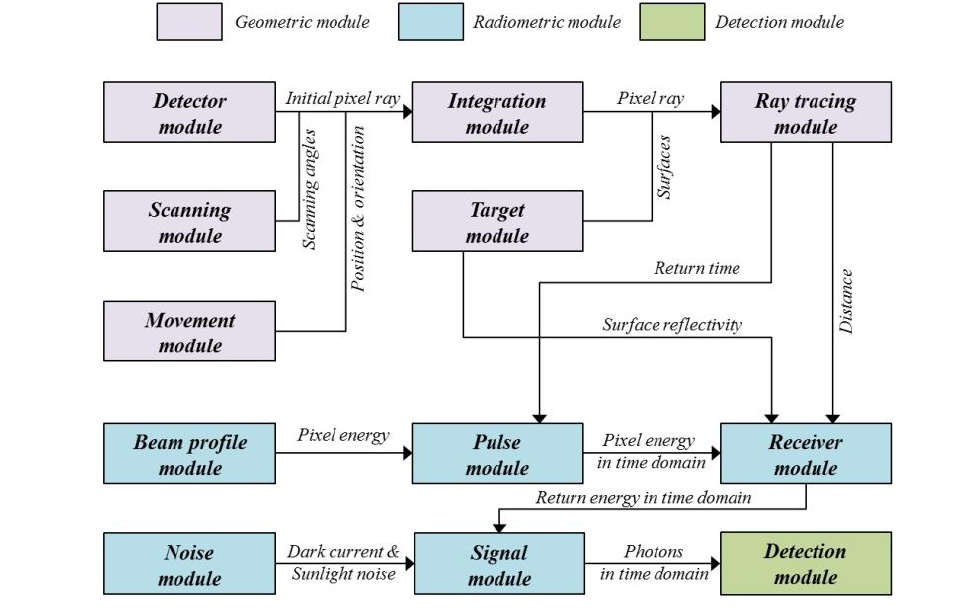
Figure 12. Main modules in the LADAR simulation program and their relationships. Geometric module outputs the range from the perspective center to the intersection point. Radiometric module computes the incident energy of each pixel from both the transmitted laser pulse and the noise and generates the number of incident photons on each pixel per time bin. Detection module calculated the simulated time at which the pixel perceives the incident photons based on the probability model.